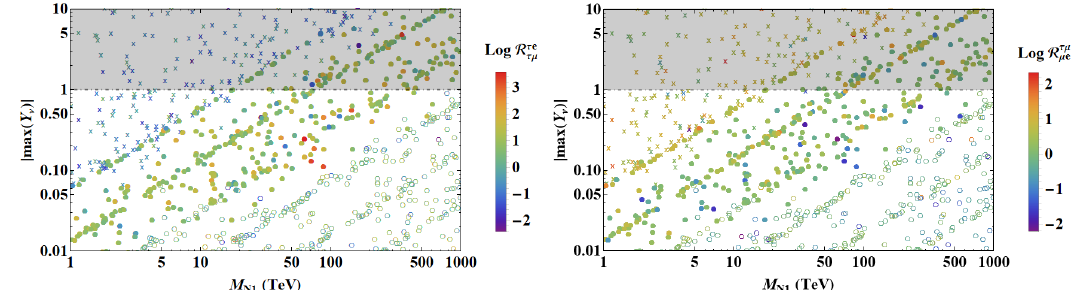
Figure 4 . Scatter plots in the plane | max ( Y ν ) | vs. M N 1 , showing in colours the value of the several parameters: left R τe and right R τµ . The plots refer to the case of NO active neutrino spectrum τµ µe with m 1 = 0 and ε = 0 . 23 . Symbols are the same as in figure 3, while colours refer now to the observables